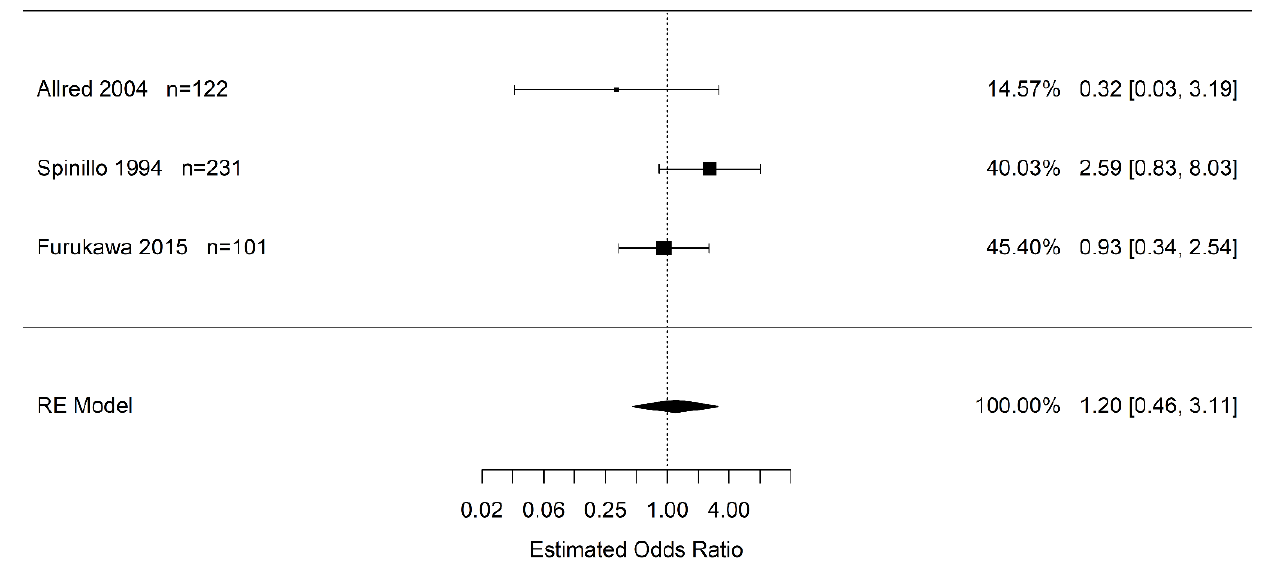
Figure 3. Estimate odds ratio of placental abruption (vs. “controls”) for severe intraventricular hemorrhage (grade 3, 4) calculated using random effects (RE) model [30,45,50]. Excluded from the meta-analysis were neonatal mortality [30,58] and HIE [46] due to an insufficient number of studies. In Furukawa et al., there were no differences in the incidence of neonatal death in women with placental abruption versus without. Matsuda et al. determined that neonatal mortality was more frequent in cases of placental abruption (11/42, 26.2%) than in placenta previa (2/72, 2.8%) and preterm labor (1/120, 0.8%), although the difference was predominantly due to cerebral palsy. HIE was only reported in one study [46], with higher incidences of moderate and severe HIE in the placental cases than in healthy term